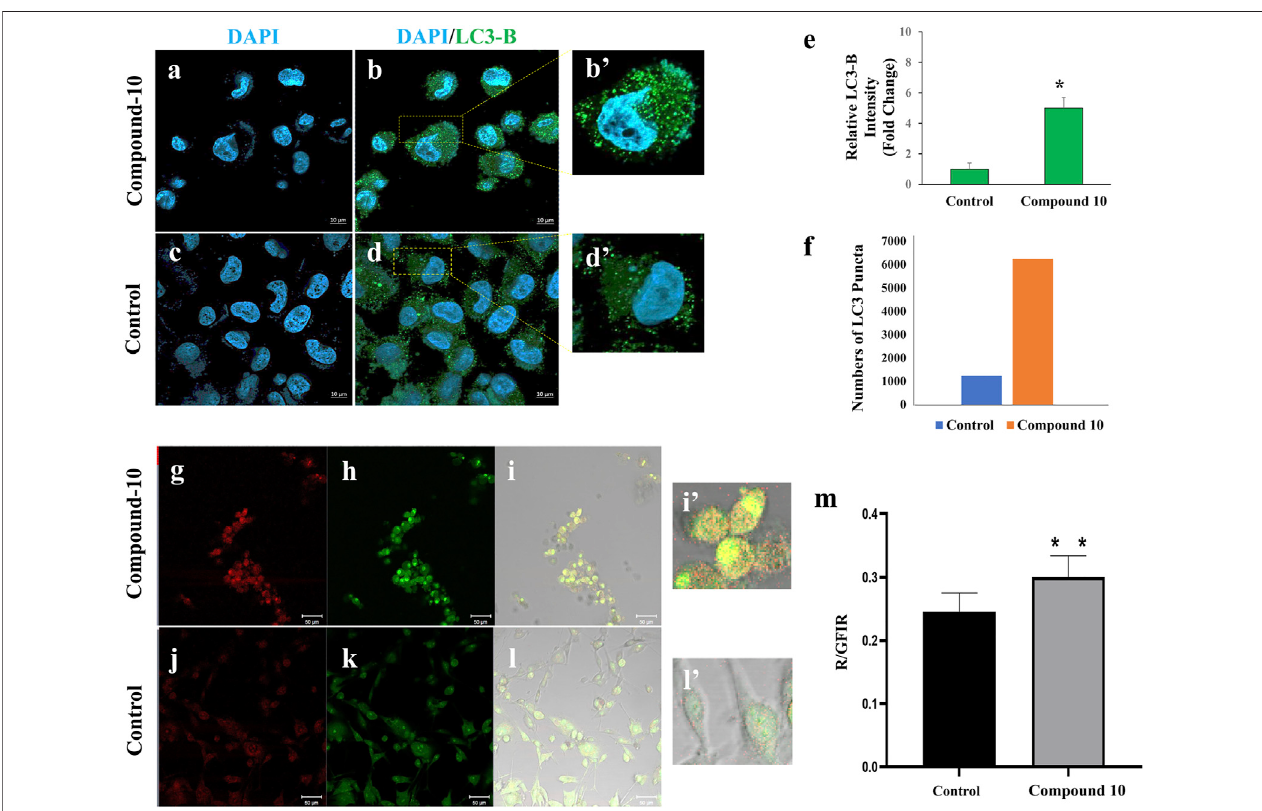
FIGURE 5 | Autophagy detection by staining LC3 and acidic compartments in C-10 – treated GBM cells. Immuno fl uorescence staining of LC3B (known as autophagymarker)inLN229cellstreatedwithC-10 (A,B) andnotreatment (C,D) for24 h.PlotshowingtherelativeincreaseofLC3Bcomparedtothecontrolgroup (E) . Numbers of LC3B puncta were increased fi vefold after C-10 treatment (F) . U87-MG cells were treated with C-10 for 24 h (only C-10 solvent was used in the control group). Acridine orange staining was used to detect autophagic cell death of the C-10 – treated cells (G-I) and the untreated controls (J-I) . Ratiometric analysis (R/ GFIR) was performed. Plot showing the rate of autophagic cell death compared to the control group (M) . [ (B ’ , D ’ , H ’ , and K ’ ) are three fold relative magni fi